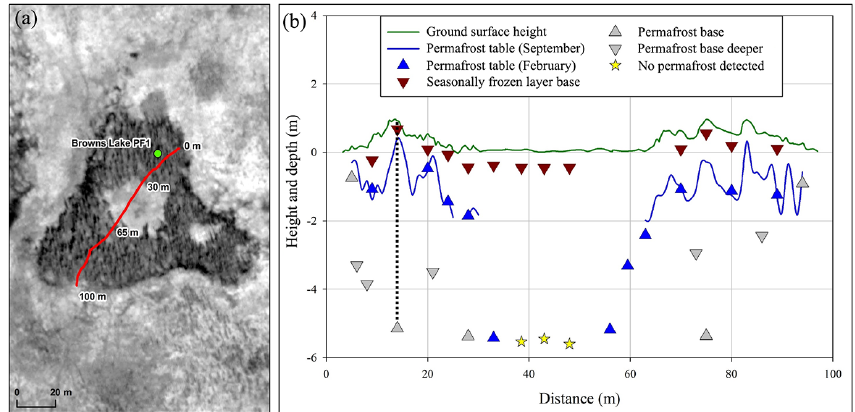
Figure 7. (a) High-resolution satellite image showing the permafrost plateau in the Browns Lake wetland complex where detailed field surveys were conducted as well as the location of the Browns Lake PF1 data logger (green dot). (b) A ∼ 100m transect across the Browns Lake PF1 permafrost plateau site showing ground surface height above the wetland (green line), depth to the permafrost table (blue line and blue arrows), permafrost thickness constraints (grey arrows), seasonally frozen ground depth (maroon arrows), and lack of permafrost (yellow stars) as measured by probing, drilling, and coring. Locations where the permafrost table exceeded 2.2m from the ground surface (limiting depth for September surveys) are indicated with a non-existent blue line. Locations where the base of the permafrost was encountered are indicated with an upward looking grey triangle and those locations where it was not encountered, a downward looking grey triangle. The black dashed vertical line represents the location of the PF-BL-6 permafrost